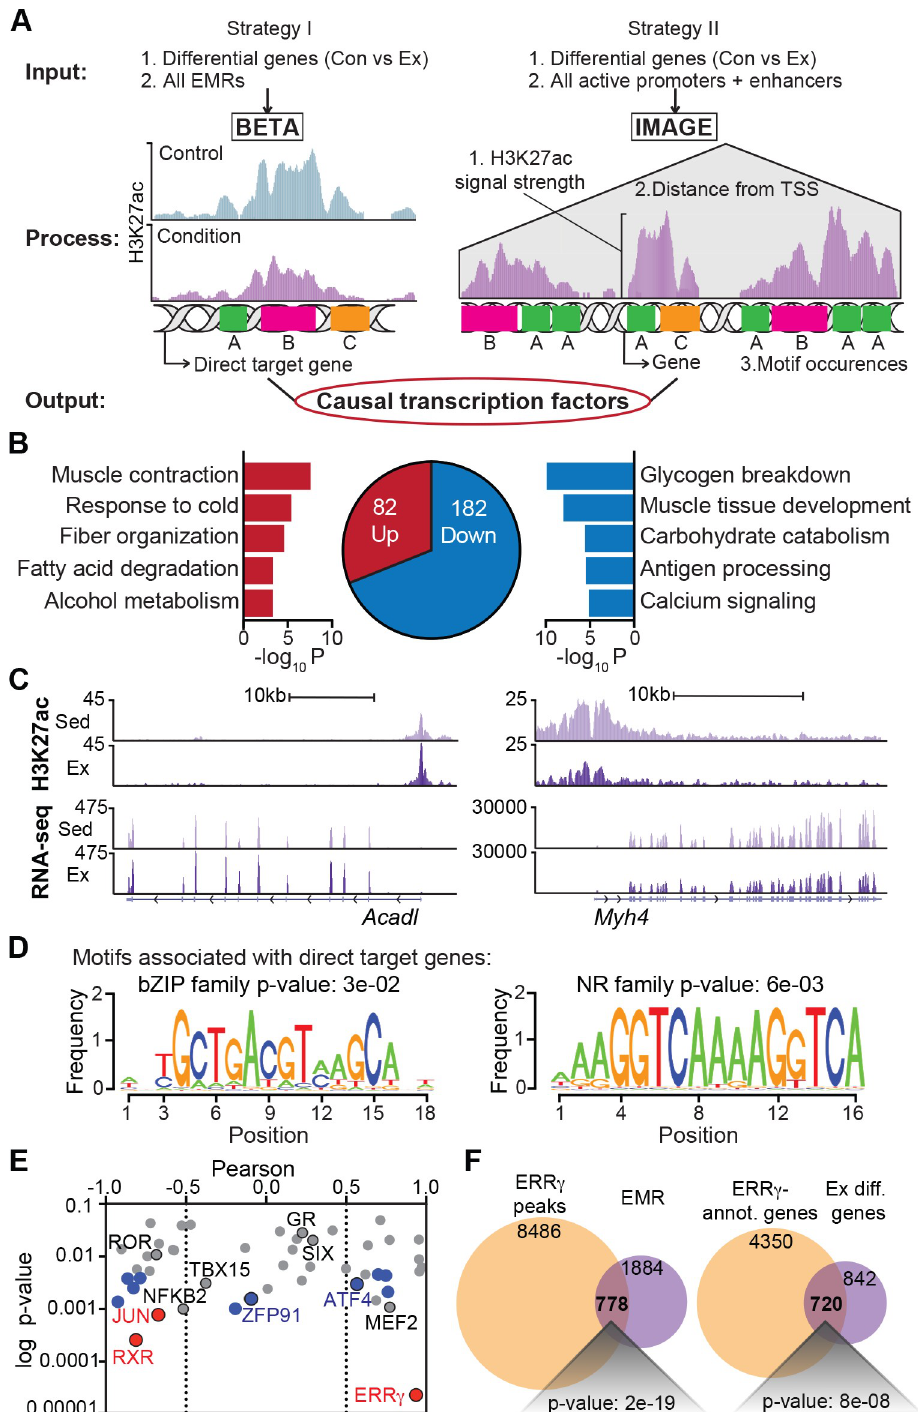
Fig 9. Integrative cis -regulatory analysis predicts causal factors for exercise-induced reprogramming. (A) Flowchart depicting the two approaches (BETA and IMAGE) used to perform integrative transcriptomic and epigenomic analysis. (B) Gene ontology analysis of differentially marked H3K27ac peaks (EMRs) associated with differentially expressed genes in Ex Quad versus Con identified by BETA. Directly up-regulated (red) and down- regulated (blue) gene numbers and ontologies are shown. (C) Representative UCSC browser tracks of H3K27ac (top) and RNA-seq (bottom) in Sed Quad (light purple) and Ex Quad (dark purple). (D) Motifs associated with the